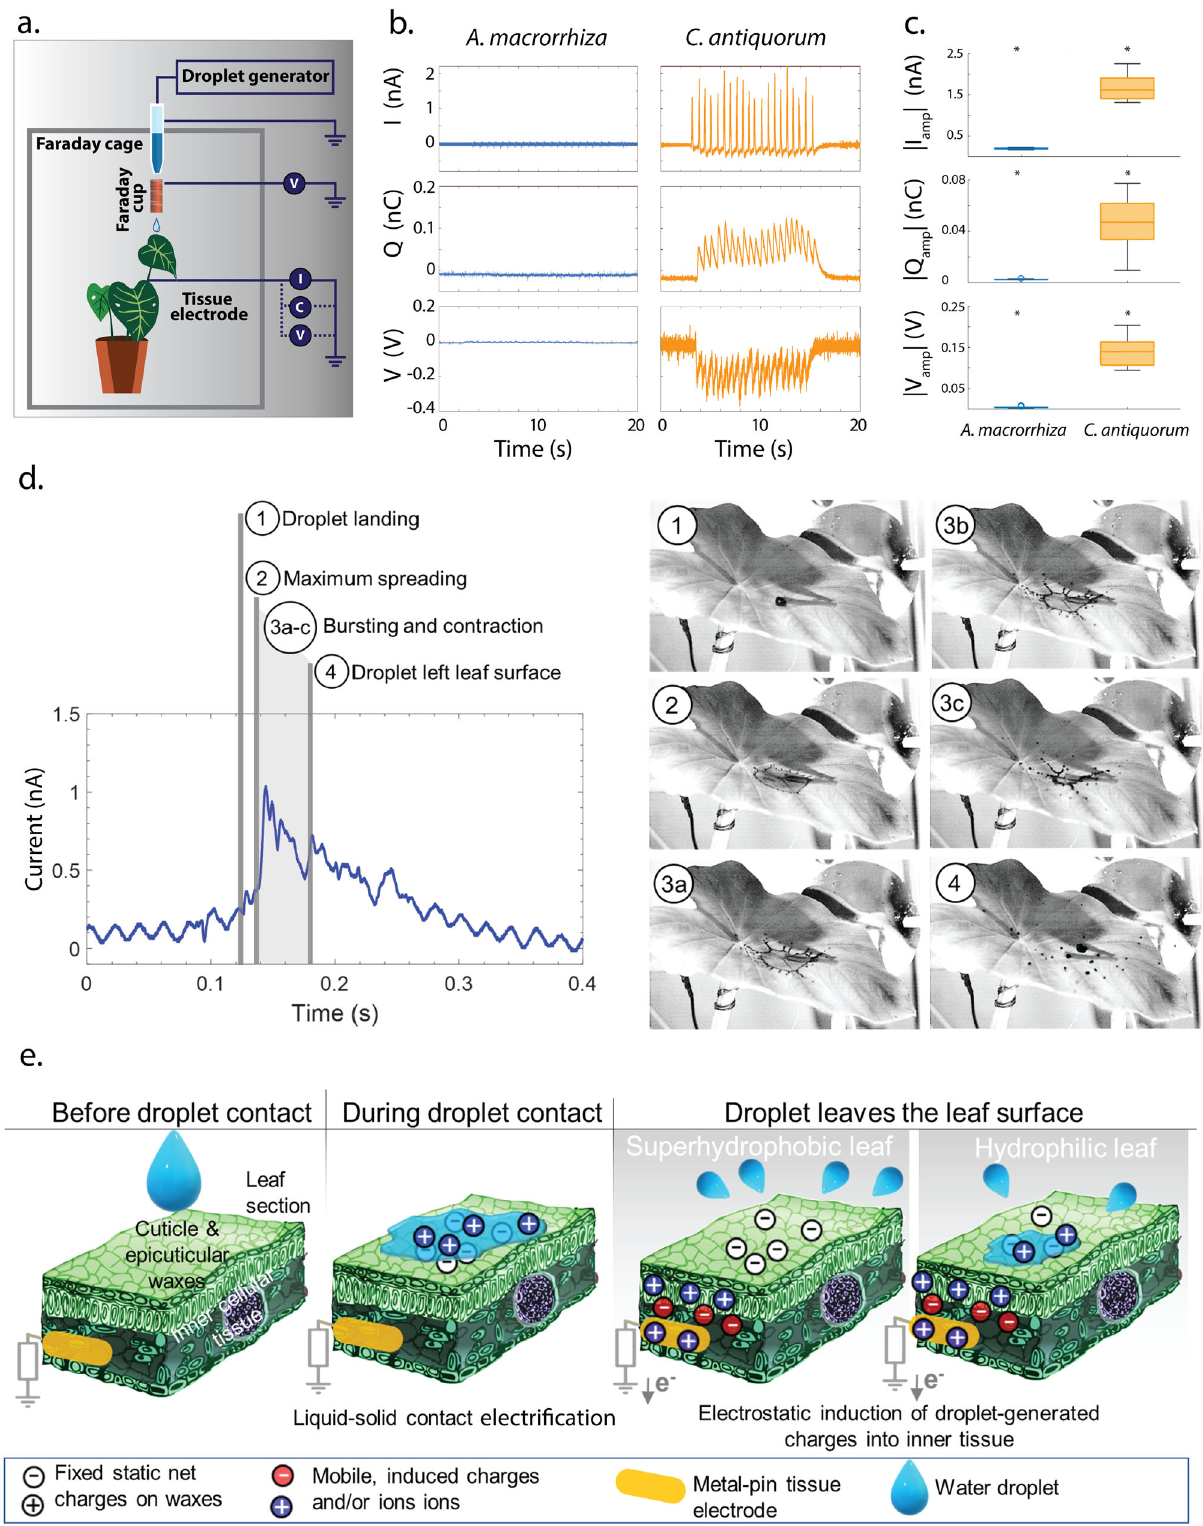
signal amplitudes are progressively suppressed. For a concentra- tion of 1 M NaCl, the signals even switch the polarity. The lower signals of A. macrorrhiza (Supplementary Fig. 10) were less affected and did not show a polarity switching. Figure 5b shows the electrical signals of C. antiquorum leaves caused by deionized water or 1 M NaCl, respectively adjusted to pH 3, 6, and 11,